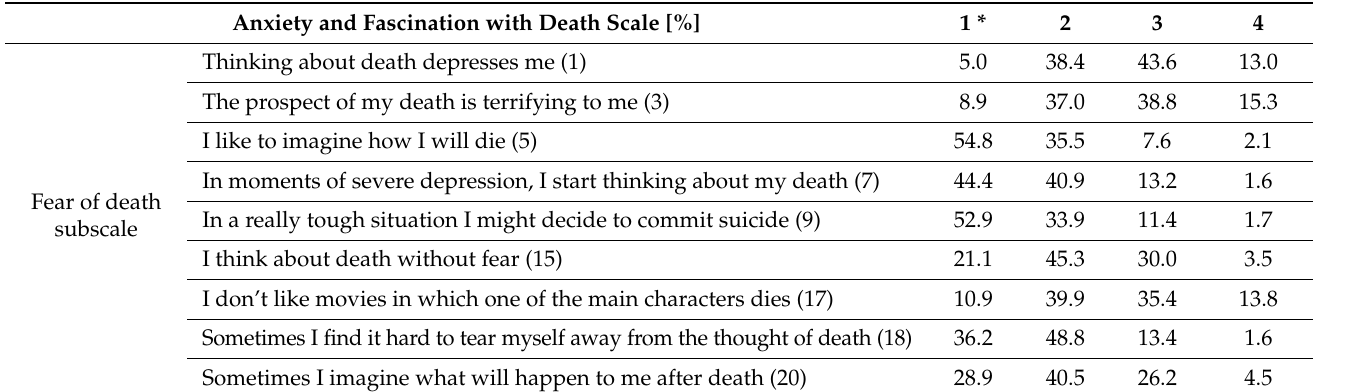
Table 4. Sub-scores of the Anxiety and Fascination with Death Scale ( N =